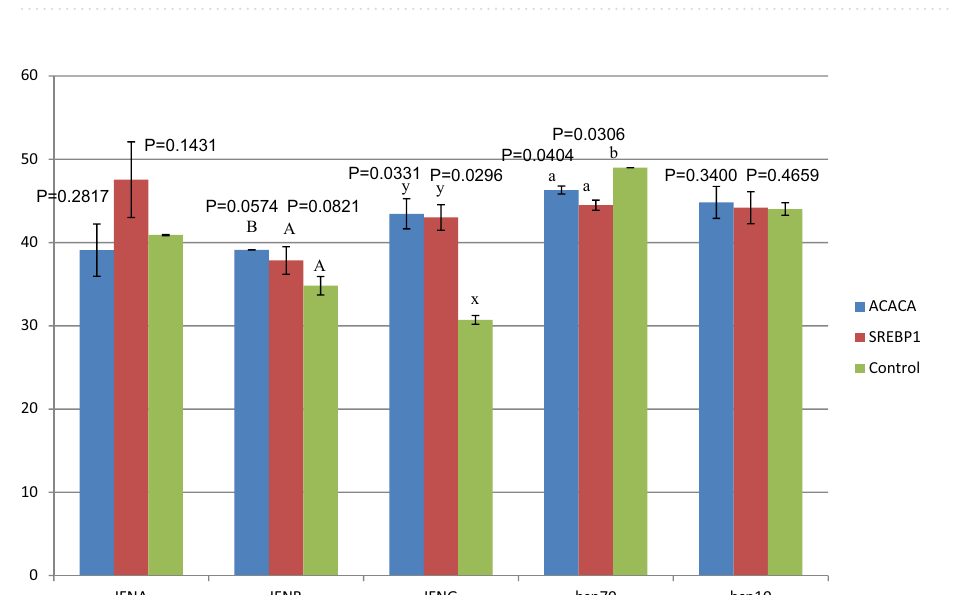
Figure 4. Expression of hsps (hsp10 and hsp70) and immune response (IFNA, IFNB and IFNG) genes in blood cells of ACACA and SREBP1 transgenic and control birds. Different superscripts (a/b) or (A/B) or (x/y) indicate significance at P < 0.05 for expression of hsp70, IFNB and IFNG genes, respectively. The IFNB expression between SREBP1 transgenic and control groups differed significantly. The IFNG expression between ACACA transgenic and control groups, and SREBP1 transgenic and control groups differed significantly. The hsp70 expression between ACACA transgenic and control, and SREBP1 transgenic and control groups differed significantly. The expression was checked at 6 weeks of age in birds of 1st